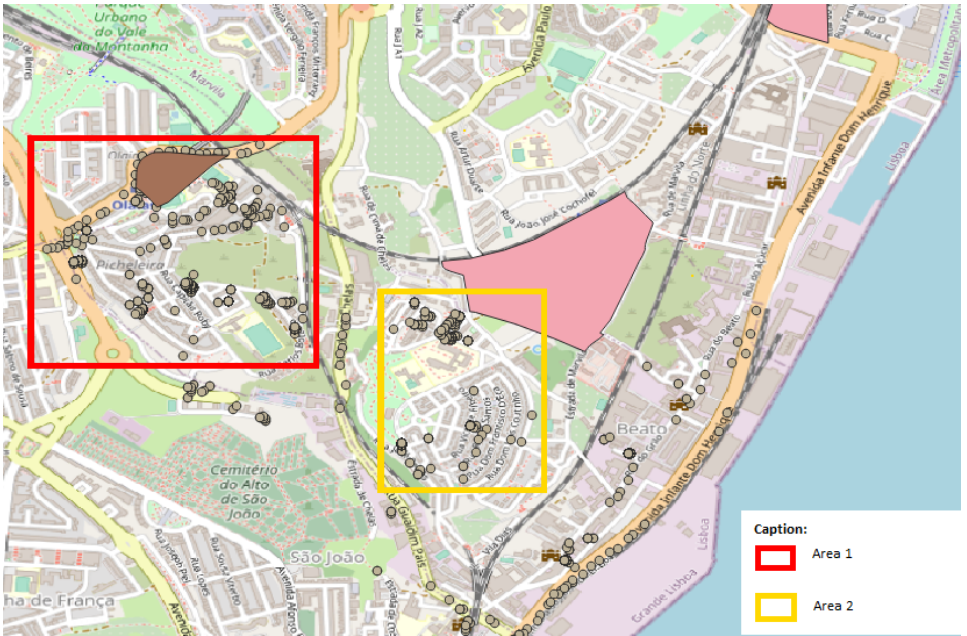
Figure 6. Interesting areas of devices concentration in Beato . Subway stations—brown; train stations— pink. Background map source: OpenStreetMap